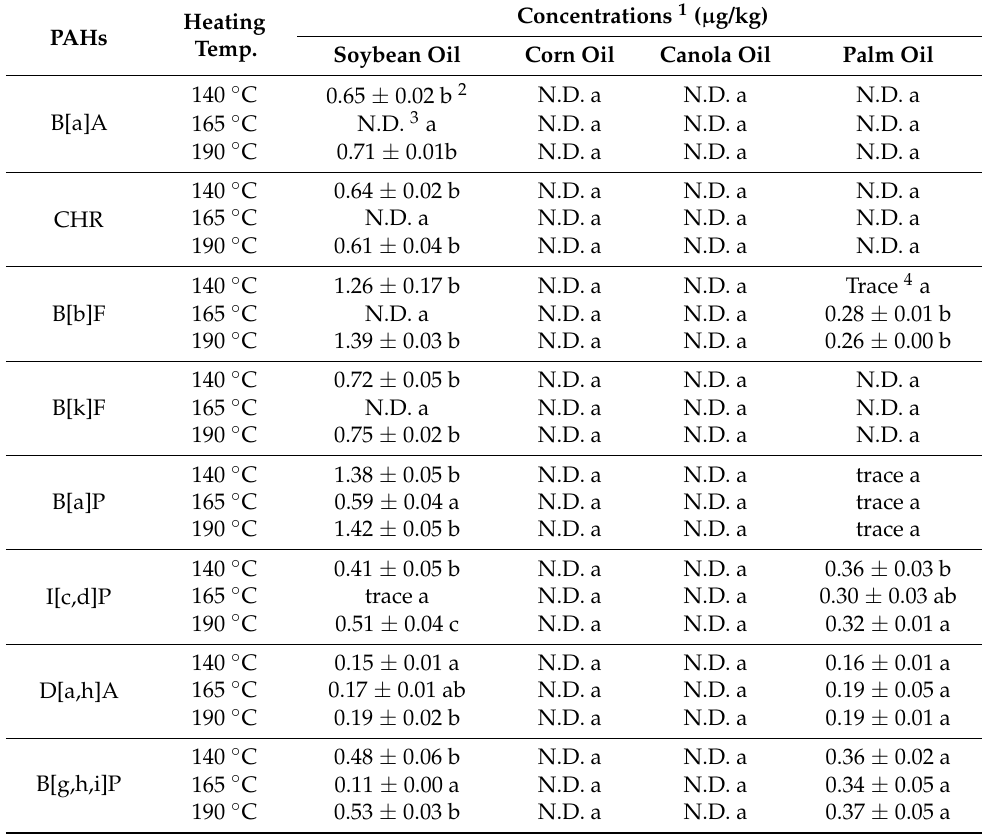
Table 1. The formation of polycyclic aromatic hydrocarbons (PAHs) in WOF (Welsh onion fried) samples at 190 ◦